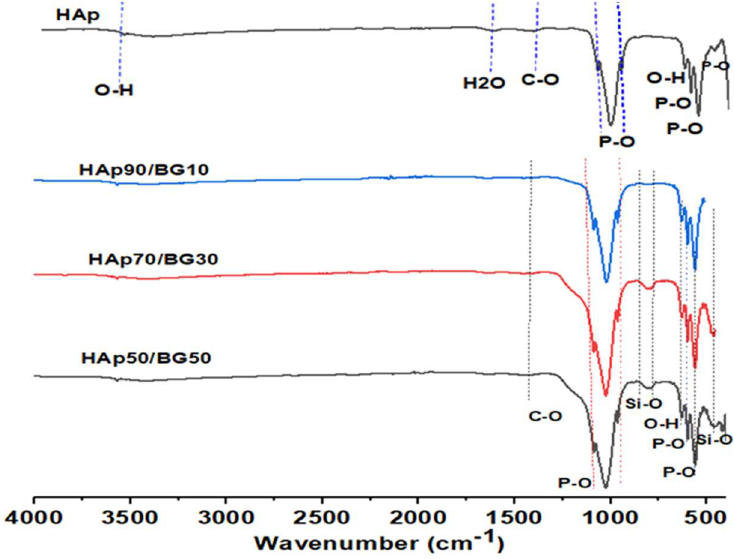
Figure 13. FTIR spectra HAp and HAp/BG composites after immersion in SBF